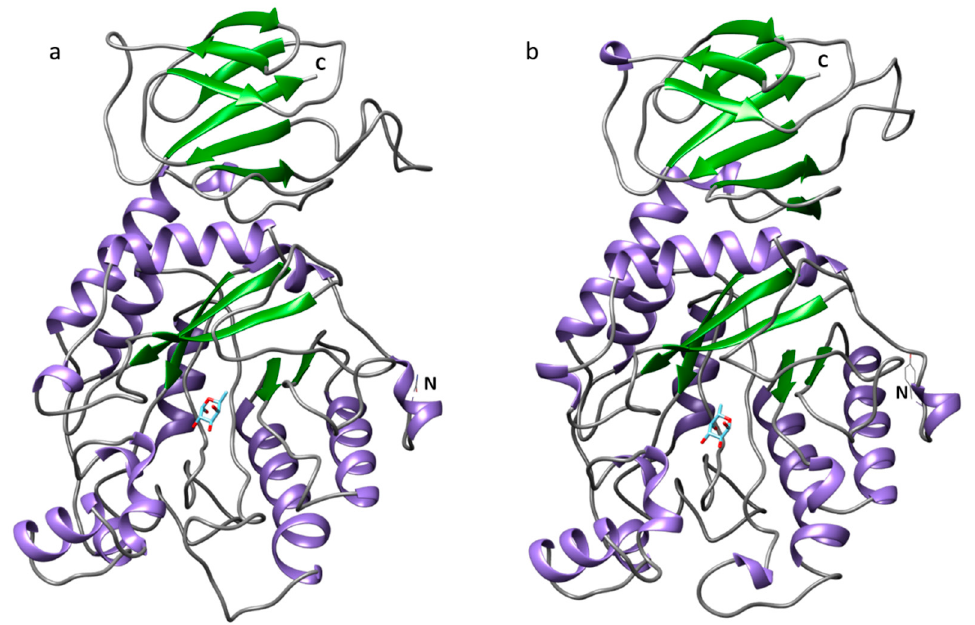
Figure 5. Predicted three-dimensional structure of two α - L -fucosidases from Bursaphelenchus xylophilus and docking of a α - L -fucose molecule. Structures were obtained using the crystal structure of α - L -fucosidase from Fusarium graminearum (PDB ID: 4ni3.1.A) as a template for BxFUCA1 ( a ) and BxFUCA2 ( b ) in SwissModel and docking of the fucose molecule was previewed in SwissDock and visualized on Chimera 1.14.